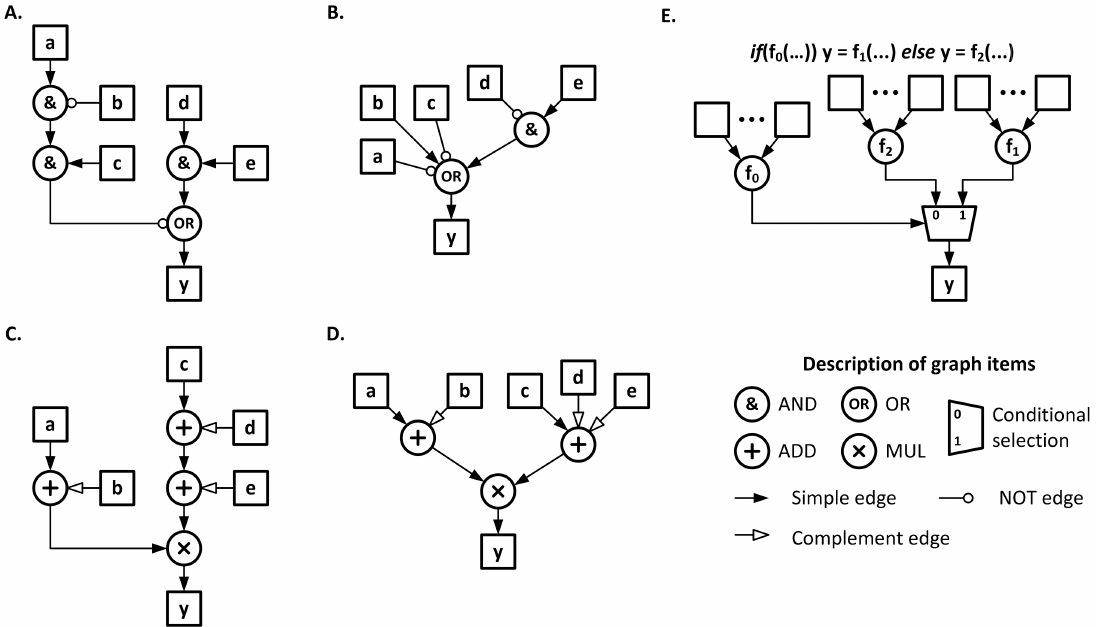
Figure 3. EFG representation of: logic expression ( A , B ), arithmetic expression ( C , D ), and conditional flow of processing ( E